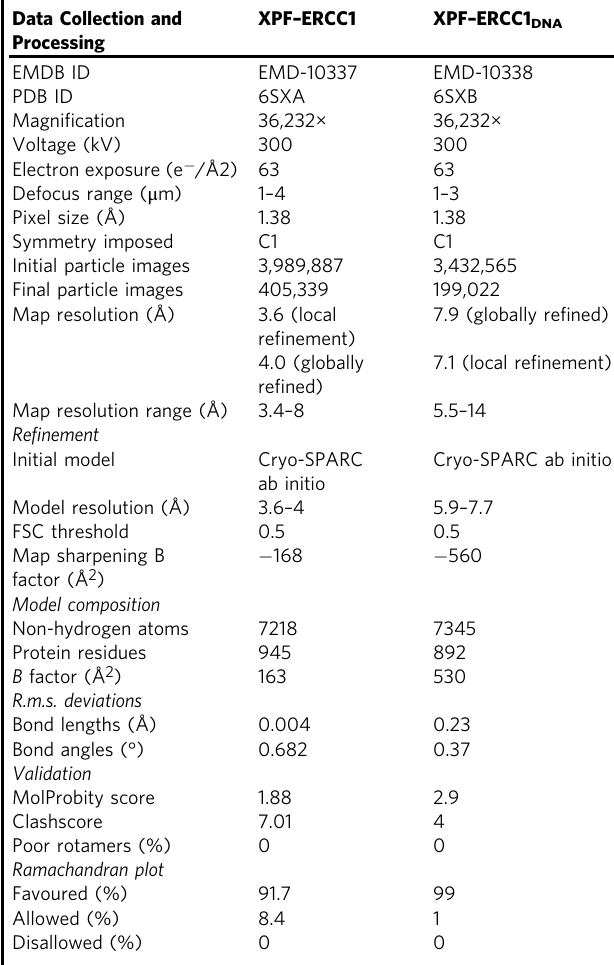
Table 4 Cryo-EM statistics for XPF – ERCC1 structures and associated